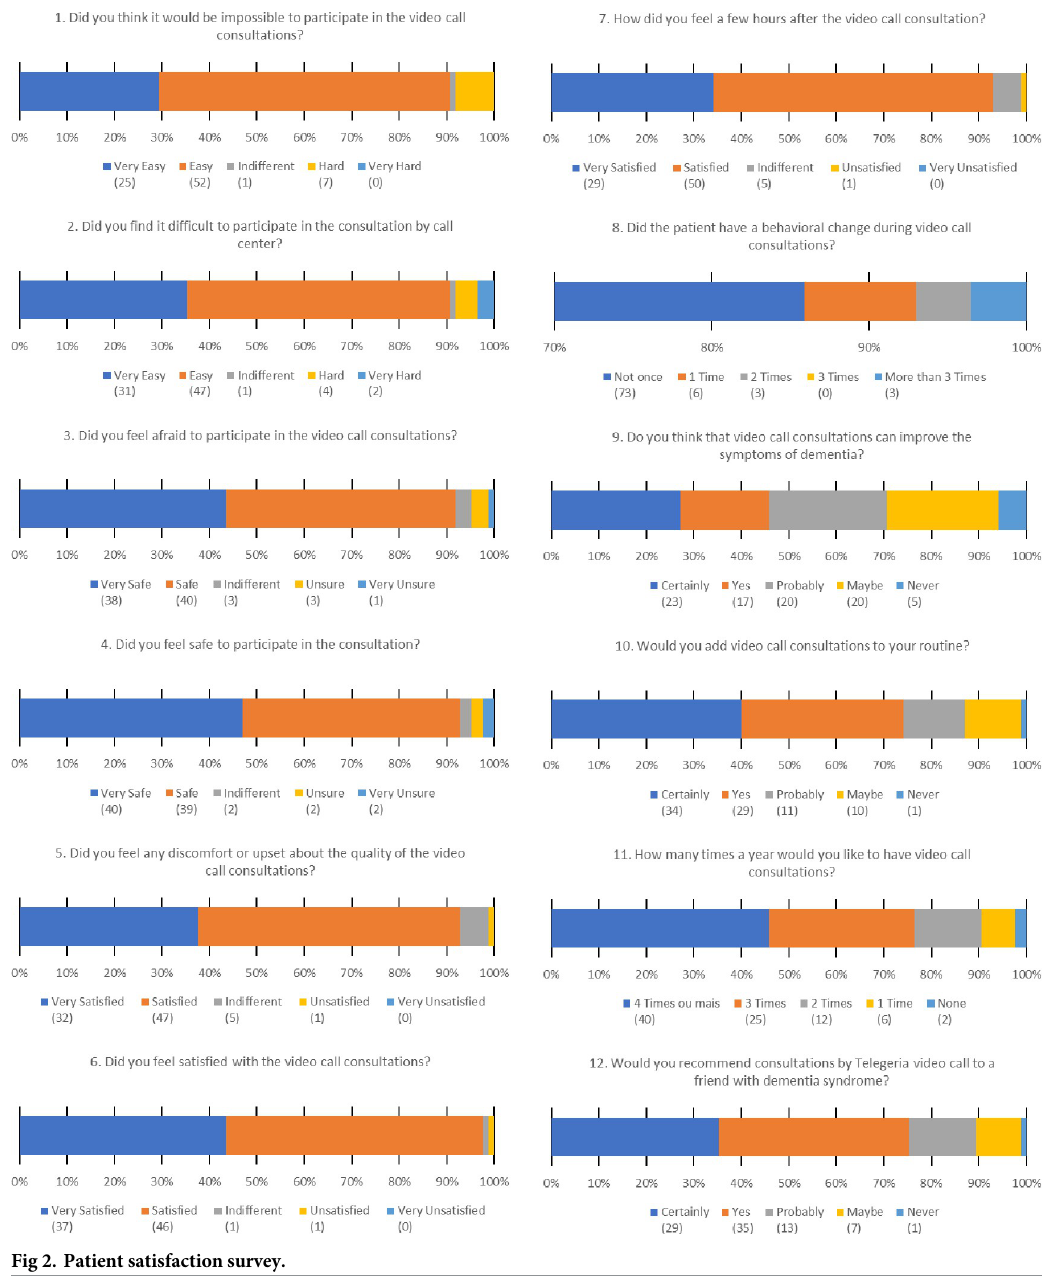
Fig 2. Patient satisfaction